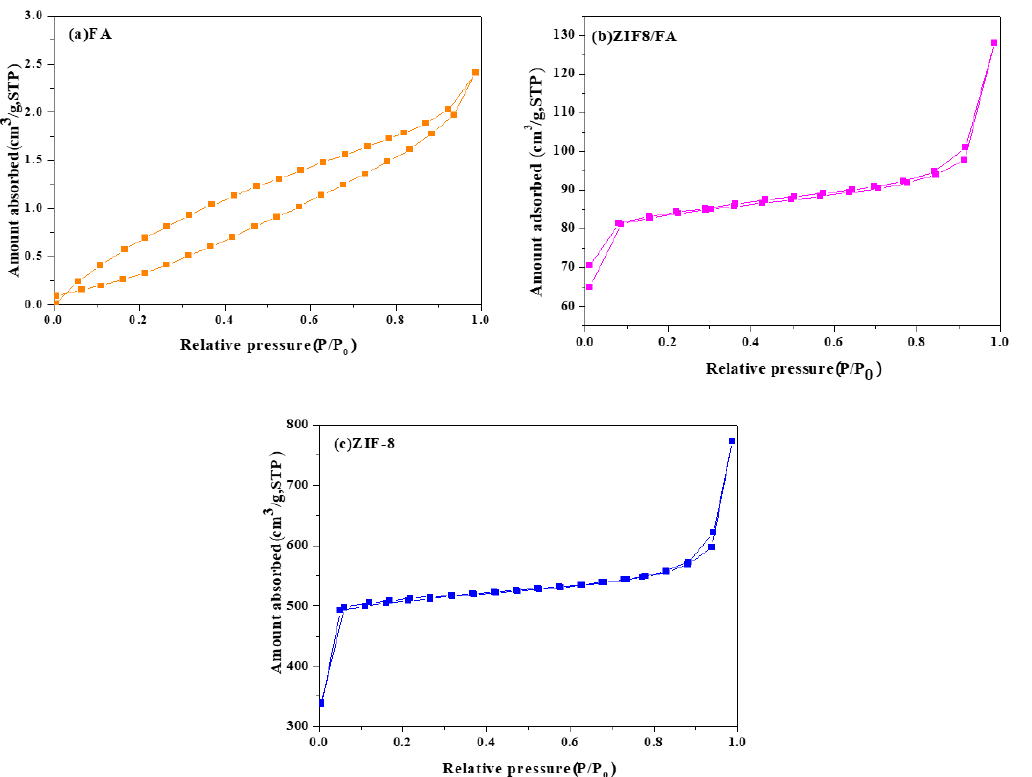
Figure 5. Nitrogen adsorption–desorption isotherms of ( a ) FA, ( b ) ZIF-8/FA, and ( c ) ZIF-8.